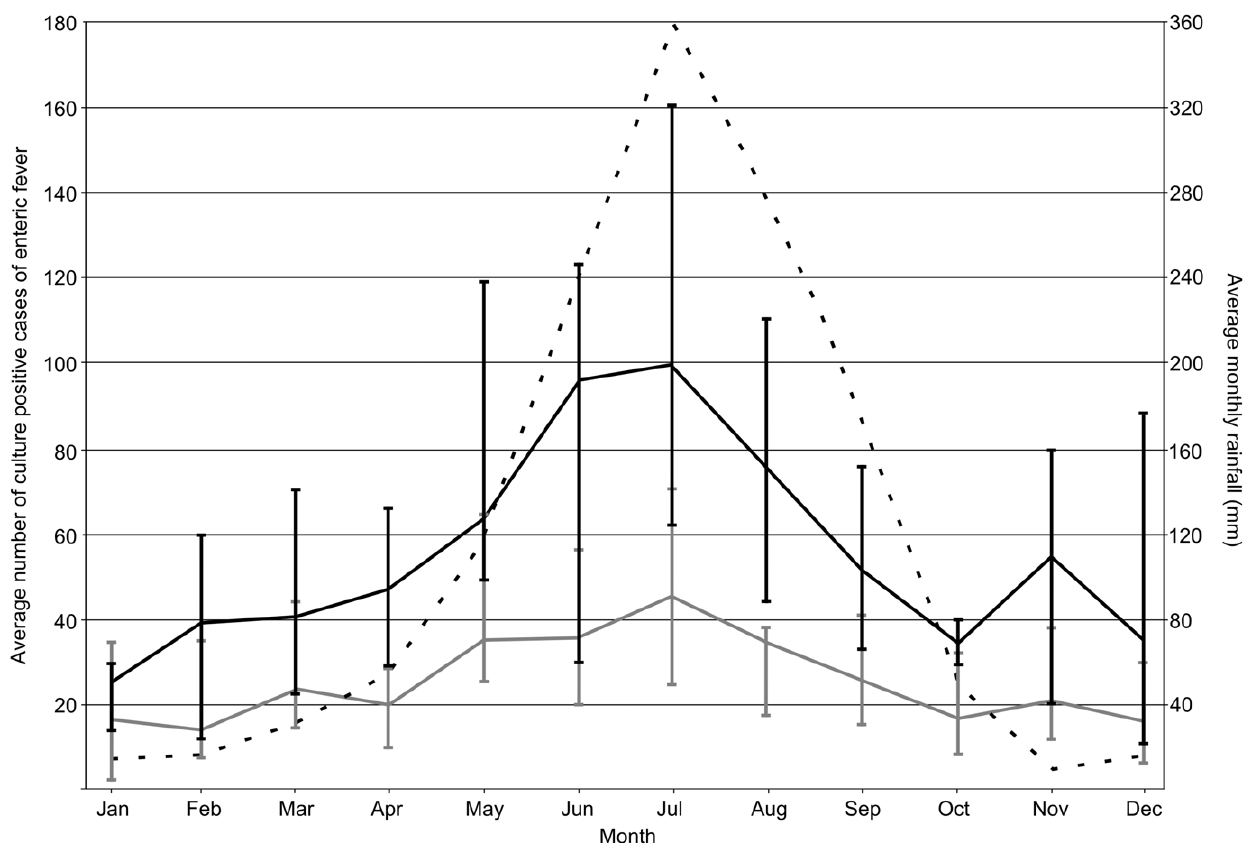
Figure 2. The seasonal distribution of enteric fever patients at Patan Hospital. Plot of the seasonal distribution of enteric fever patients at Patan Hospital in Kathmandu. The average number of S. Typhi cases (black line) and S. Paratyphi A cases (grey line) for each month of the year was calculated over the period June 2005–May 2009. Vertical lines represent the range over the four year period for each month. The average monthly rainfall (mm) is shown by the broken black line and corresponds with the secondary y axis.